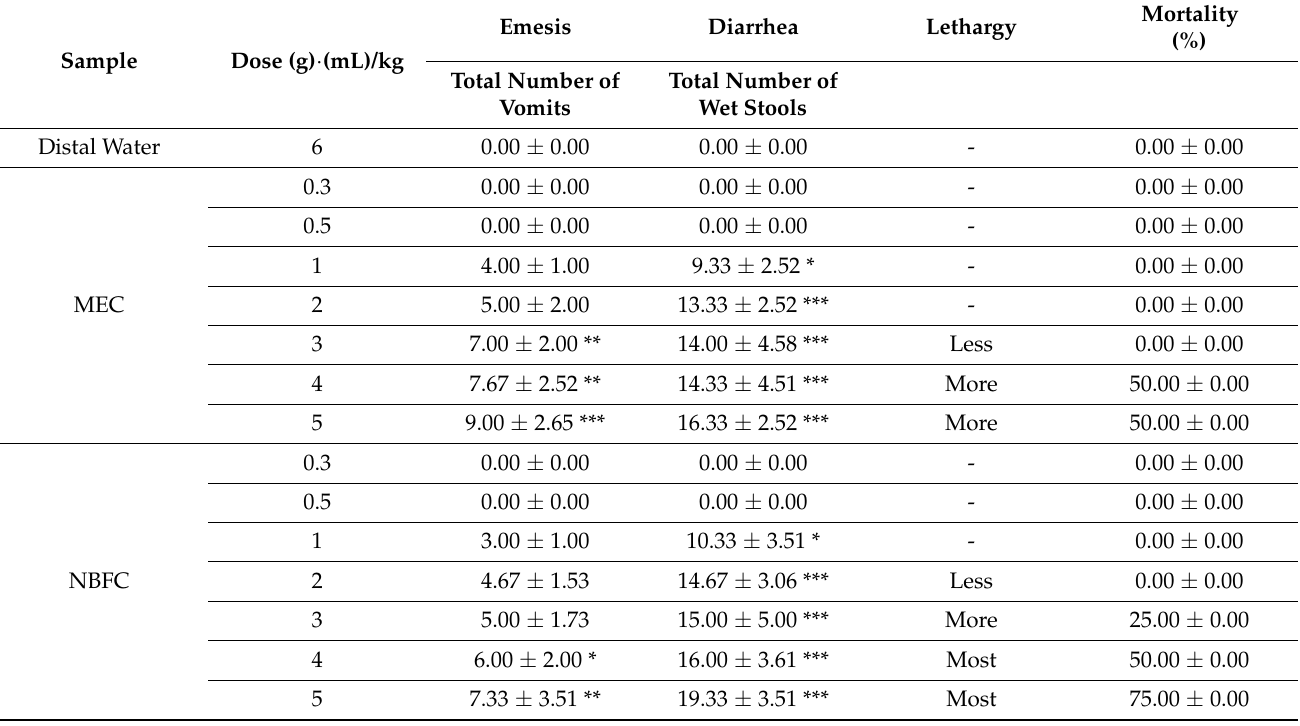
Table 4. Acute toxicity of methanolic extract and n -butanol fractions of Chrozophora tinctoria in